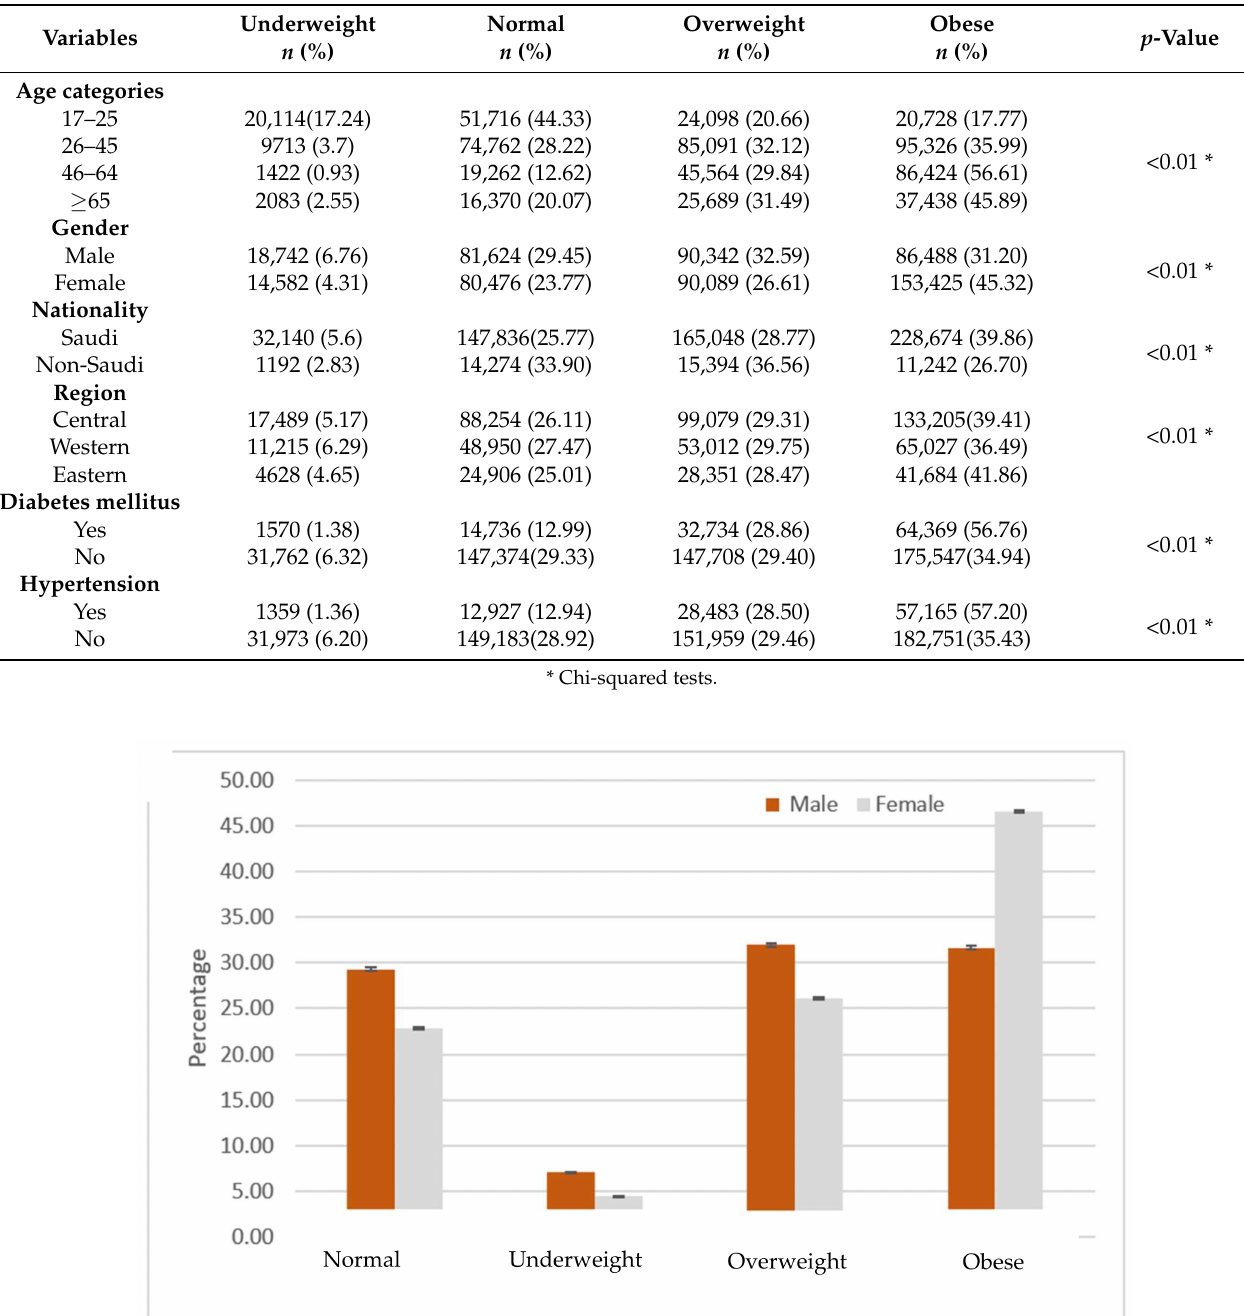
Table 2. Descriptive characteristics of the study population by BMI category.